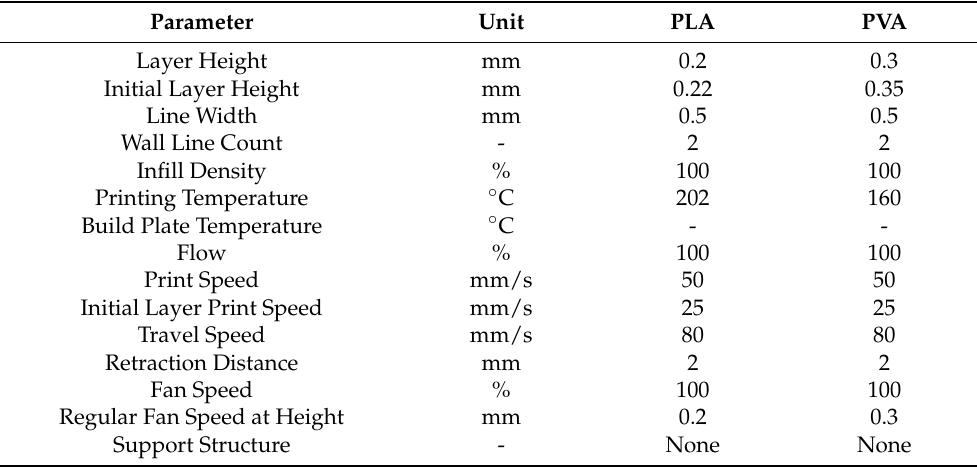
Table 1. Slicing printing settings used for both PLA and PVA